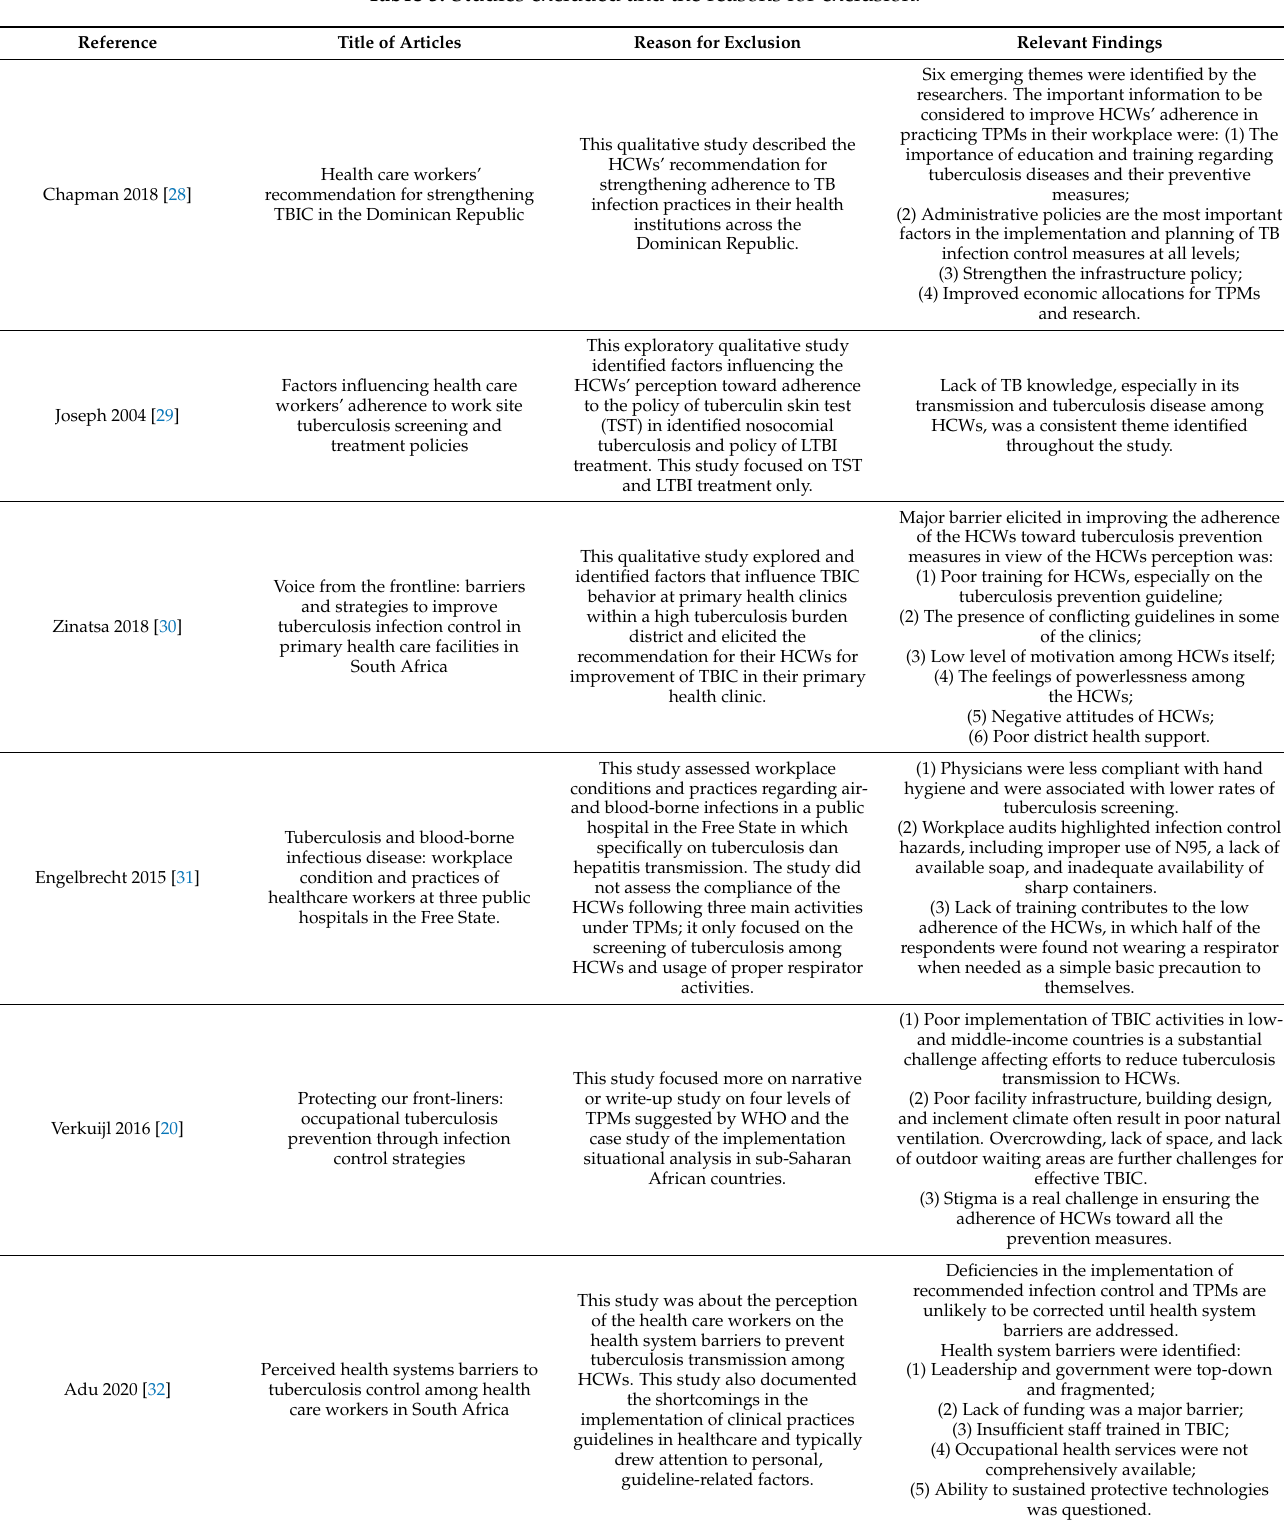
Table 5. Studies excluded and the reasons for